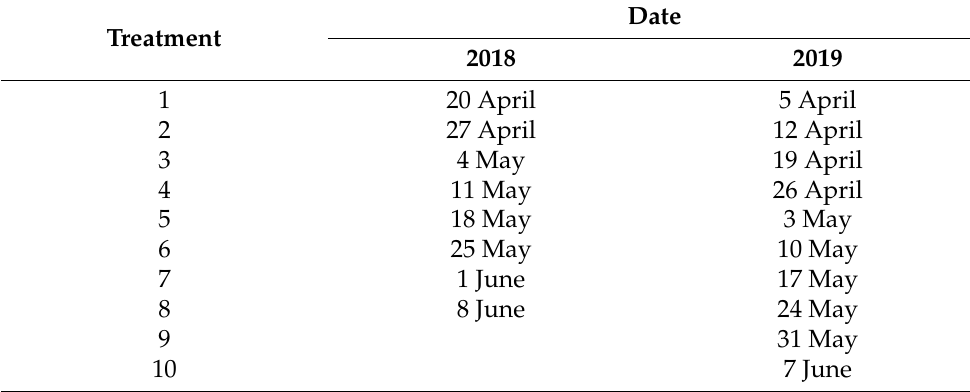
Table 1. The dates of spring rapeseed